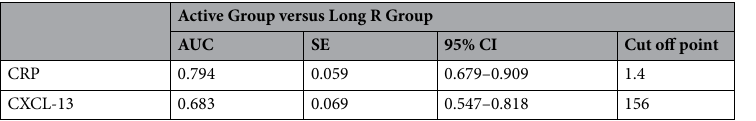
Table 4. Receiver operating characteristic curve analysis for CXCL-13 and CRP comparing the Active Group with the Long R Group. AUC area under the curve, CRP C-reactive protein, CXCL-13 chemokine CXC ligand 13, SE standard error.